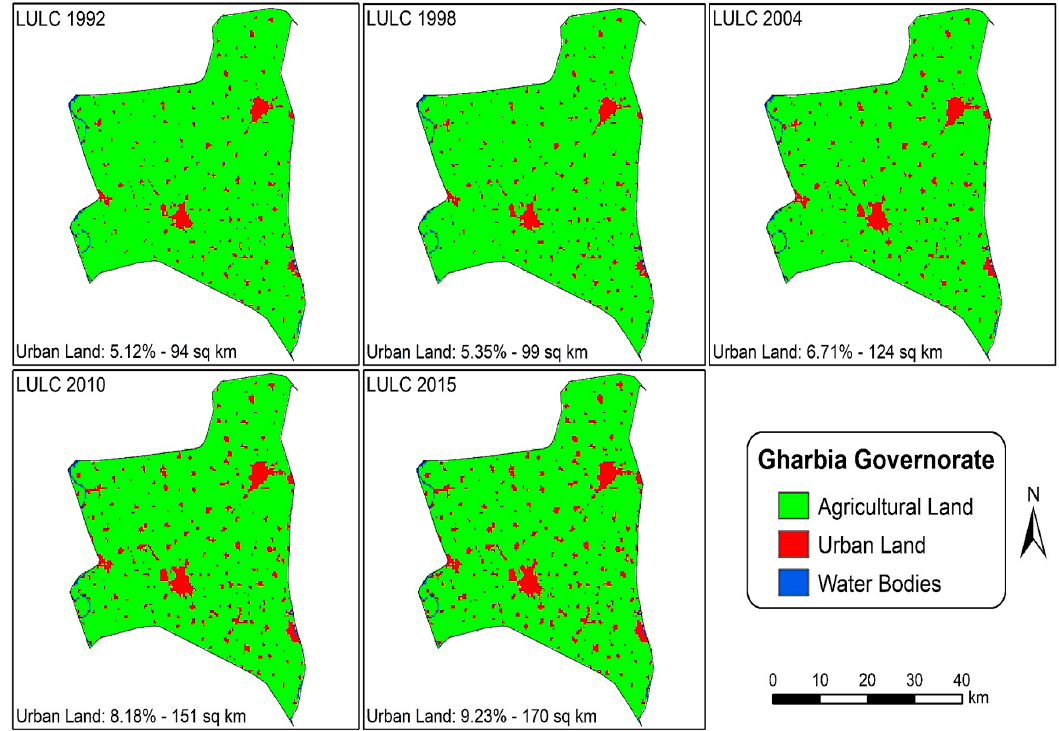
Figure A2. Urban expansion over Gharbia governorate.